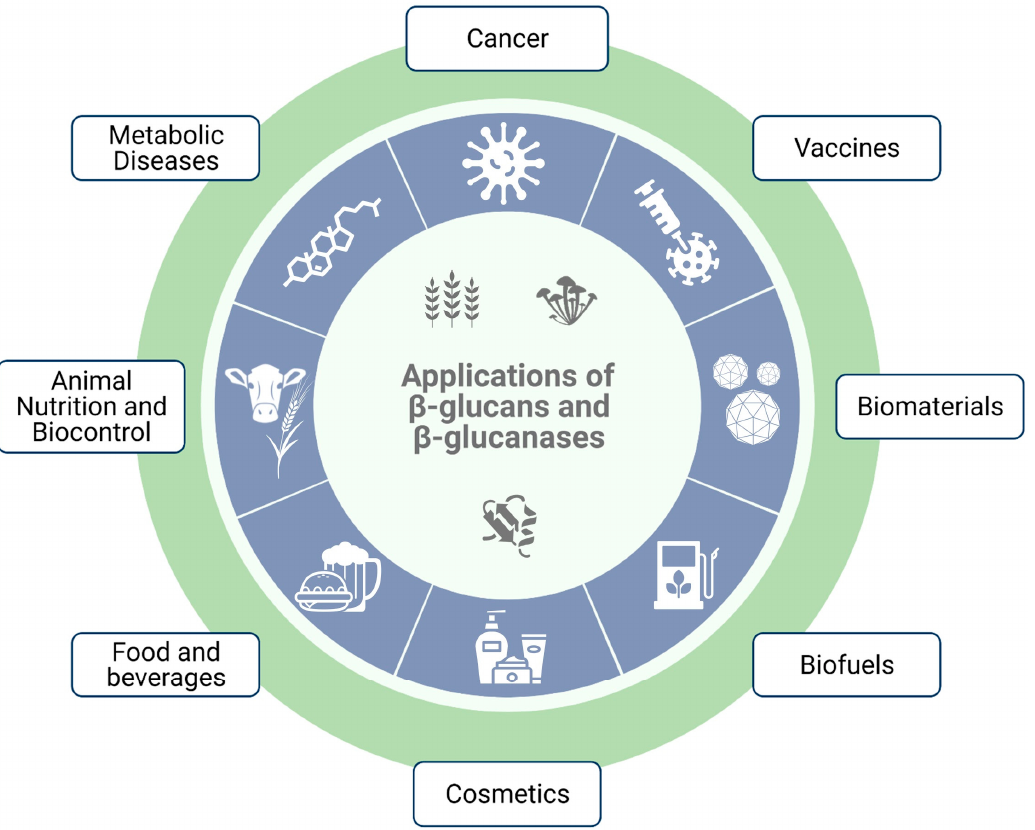
Figure 1. The applications of β -glucans and β -1,3-glucanases. Due to their unique physicochemical and bioactive properties, β -glucans and their processing enzymes are attractive molecules with mul- tiple applications, ranging from cancer treatment to brewing.